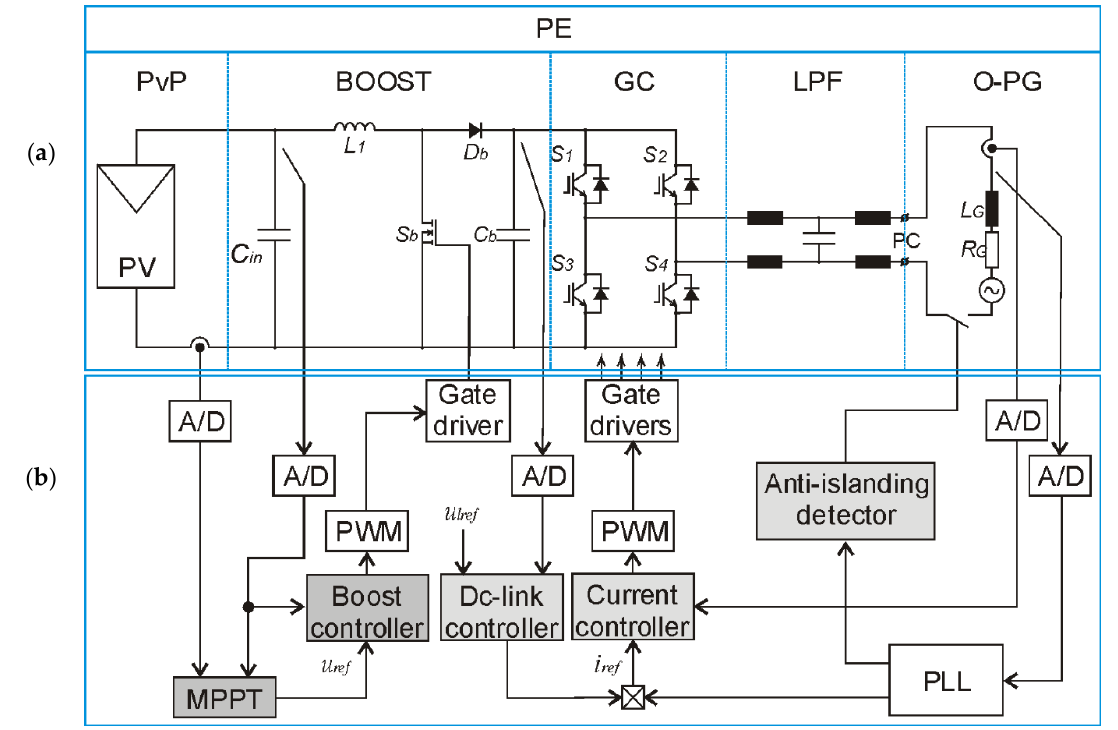
Figure 1. One-phase photovoltaic system diagram: ( a ) power electronics part; ( b ) control structure .